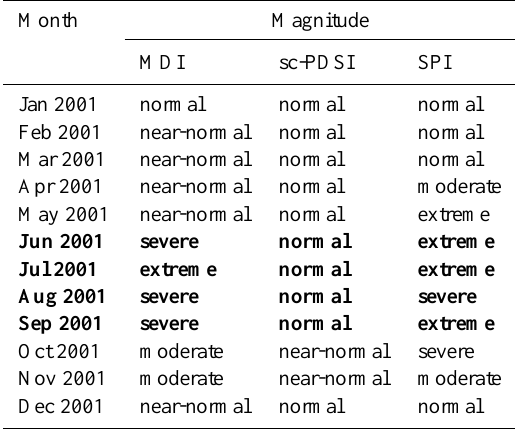
Table 6. The dryness assessment of the 2001 drought by MDI, sc- PDSI and